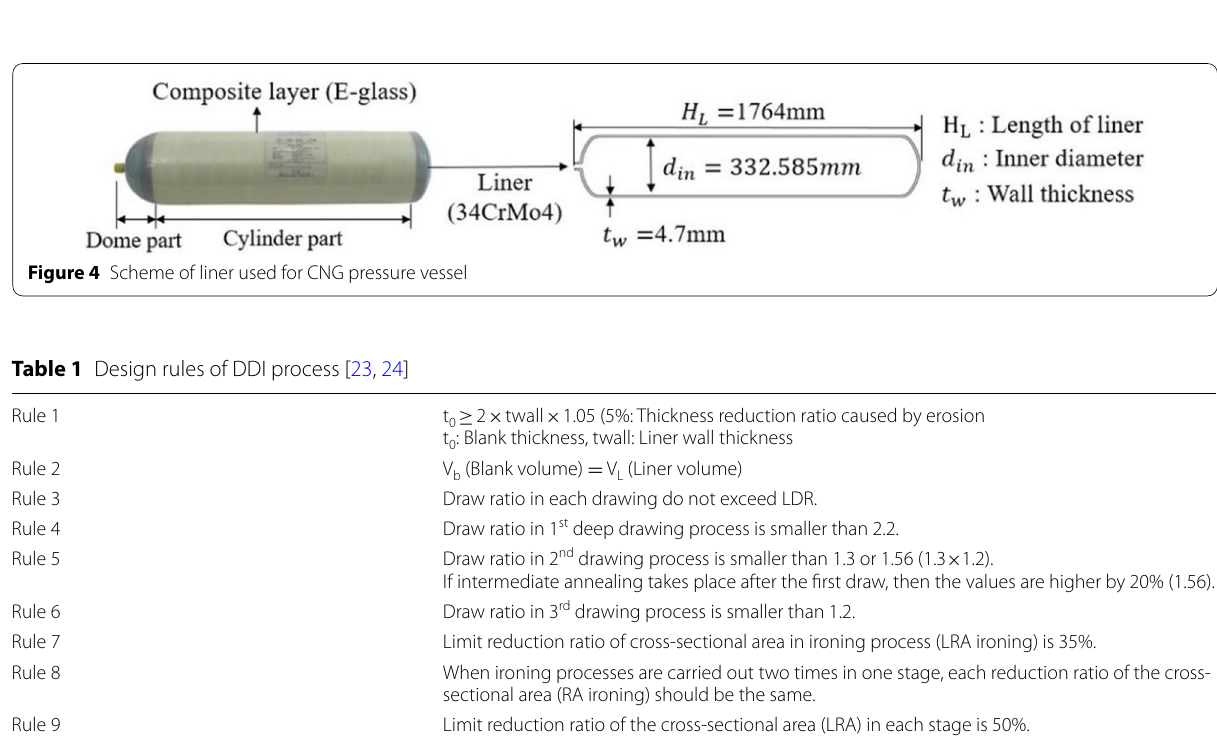
Figure 3 Configuration for determination of initial blank thickness and shape of tractrix die